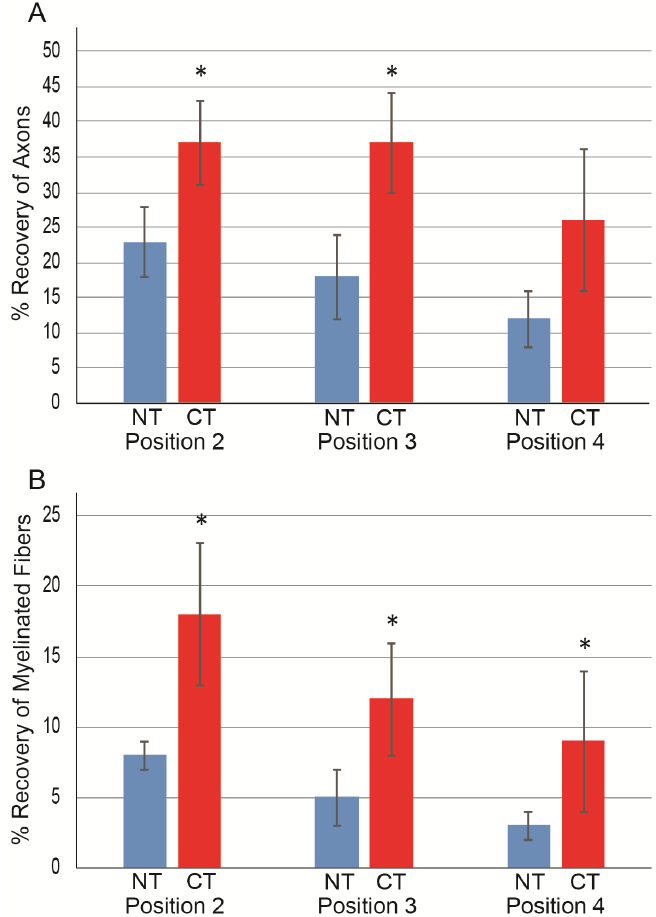
Figure 5. Recovery ratio of axons and myelinated fibers in each position in the CT ( n = 6) and NT ( n = 10) groups. Data were calculated based on pooled values of non ‐ damaged upstream position 1 in both groups ( n = 20) as N200; 4625 ± 142, MBP; 3329 ± 114. ( A ) Axon recovery ratio; ( B ) myelinated fiber recovery. Individual values are presented as the mean ± S.E. * p < 0.05 (CT vs. NT). NT, non ‐ cytokine control group; CT, cytokine group.